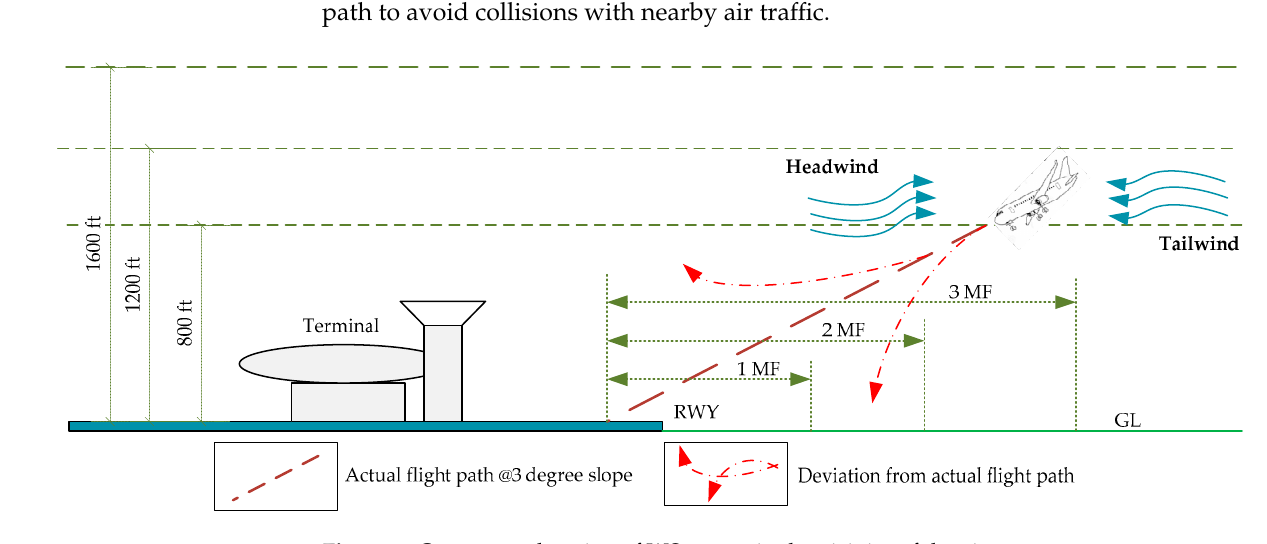
Table 1. Literature on various factors contributing to the occurrence of aircraft go-around.